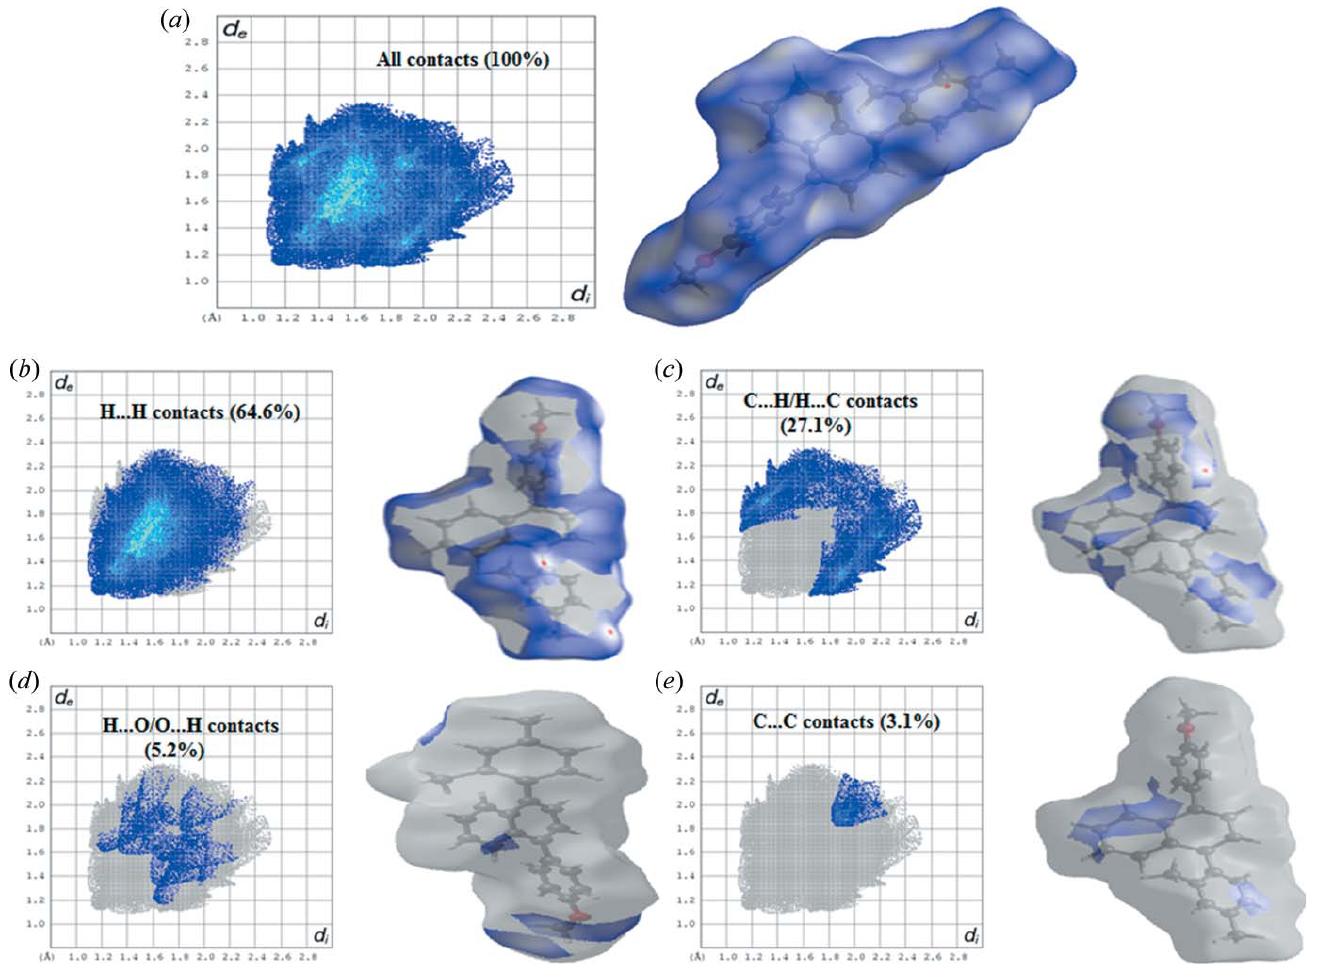
Figure 4 Two-dimensional fingerprint plot for the title compound showing the contributions of individual types of interactions: ( a ) all intermolecular contacts, ( b ) H (cid:2)(cid:2)(cid:2) H contacts, ( c ) C (cid:2)(cid:2)(cid:2) H/H (cid:2)(cid:2)(cid:2) C contacts, ( d ) H (cid:2)(cid:2)(cid:2) O/O (cid:2)(cid:2)(cid:2) H contacts, ( e ) C (cid:2)(cid:2)(cid:2) C contacts. The outline of the full fingerprint is shown in grey. Surfaces to the right highlight the relevant surface patches associated with the specific contacts with d norm mapped.